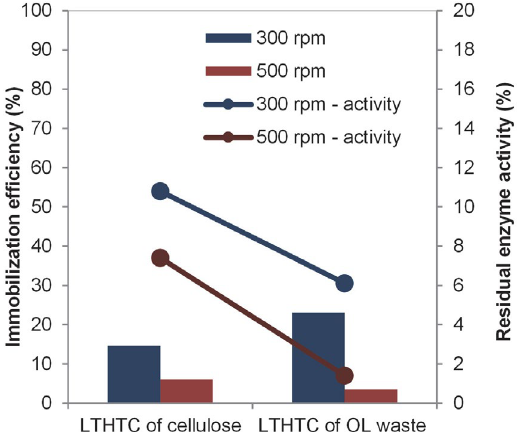
Figure 5. Influence of agitation speed on immobilization efficiency and residual enzyme activity. Reaction conditions: 5 mg of chosen biochar, enzyme concentration of 2.3 mg/mL, crosslinker PEHA, PBS with pH 7, 7-h immobilization of enzyme with continuous stir- ring at ambient temperature and at atm. pressure. Standard devia- tion for all measurements was less than ±